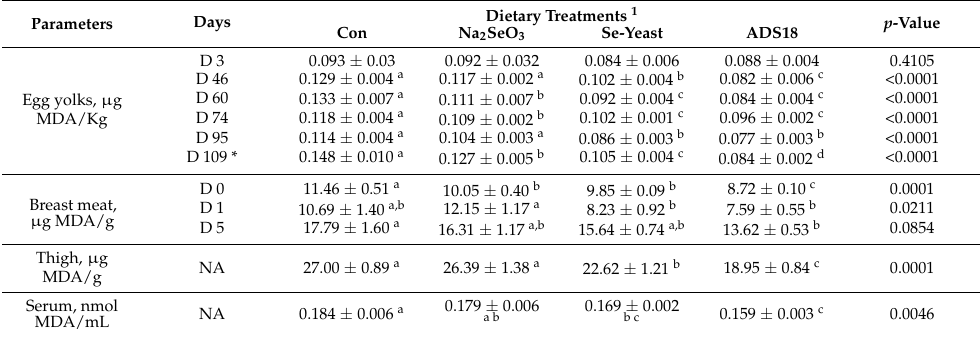
Table 6. Effects of different Se sources on oxidative stability of pre-and post-stored egg yolk, breast, and thigh